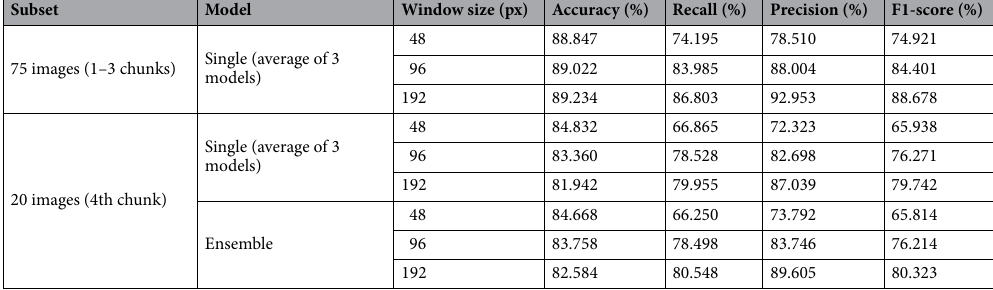
Table 1. The collective comparison of fragments classification of the examined models. The presented values are averaged within the indicated subset. Each subset’s image was evaluated by models, which had not been trained on it (as described in the “Data” section).